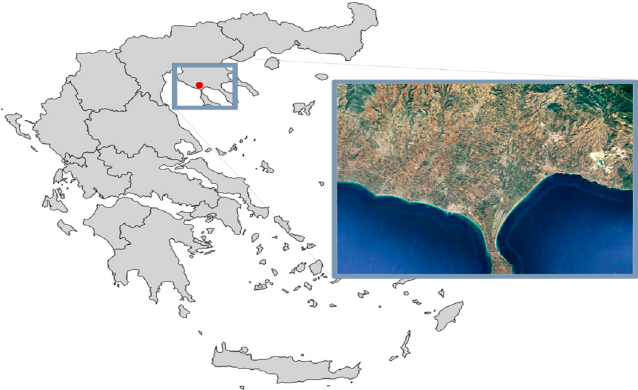
Figure 1. Test site of the olive orchards located in the region of Halkidiki, Northern Greece.